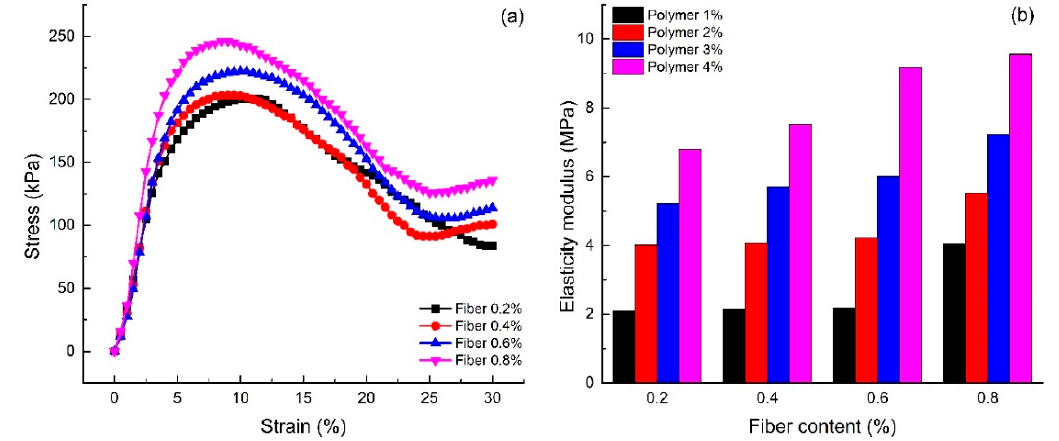
Figure 7. Effect of fiber content on unconfined compression test: ( a ) Stress-strain curves; ( b ) Elasticity modulus.